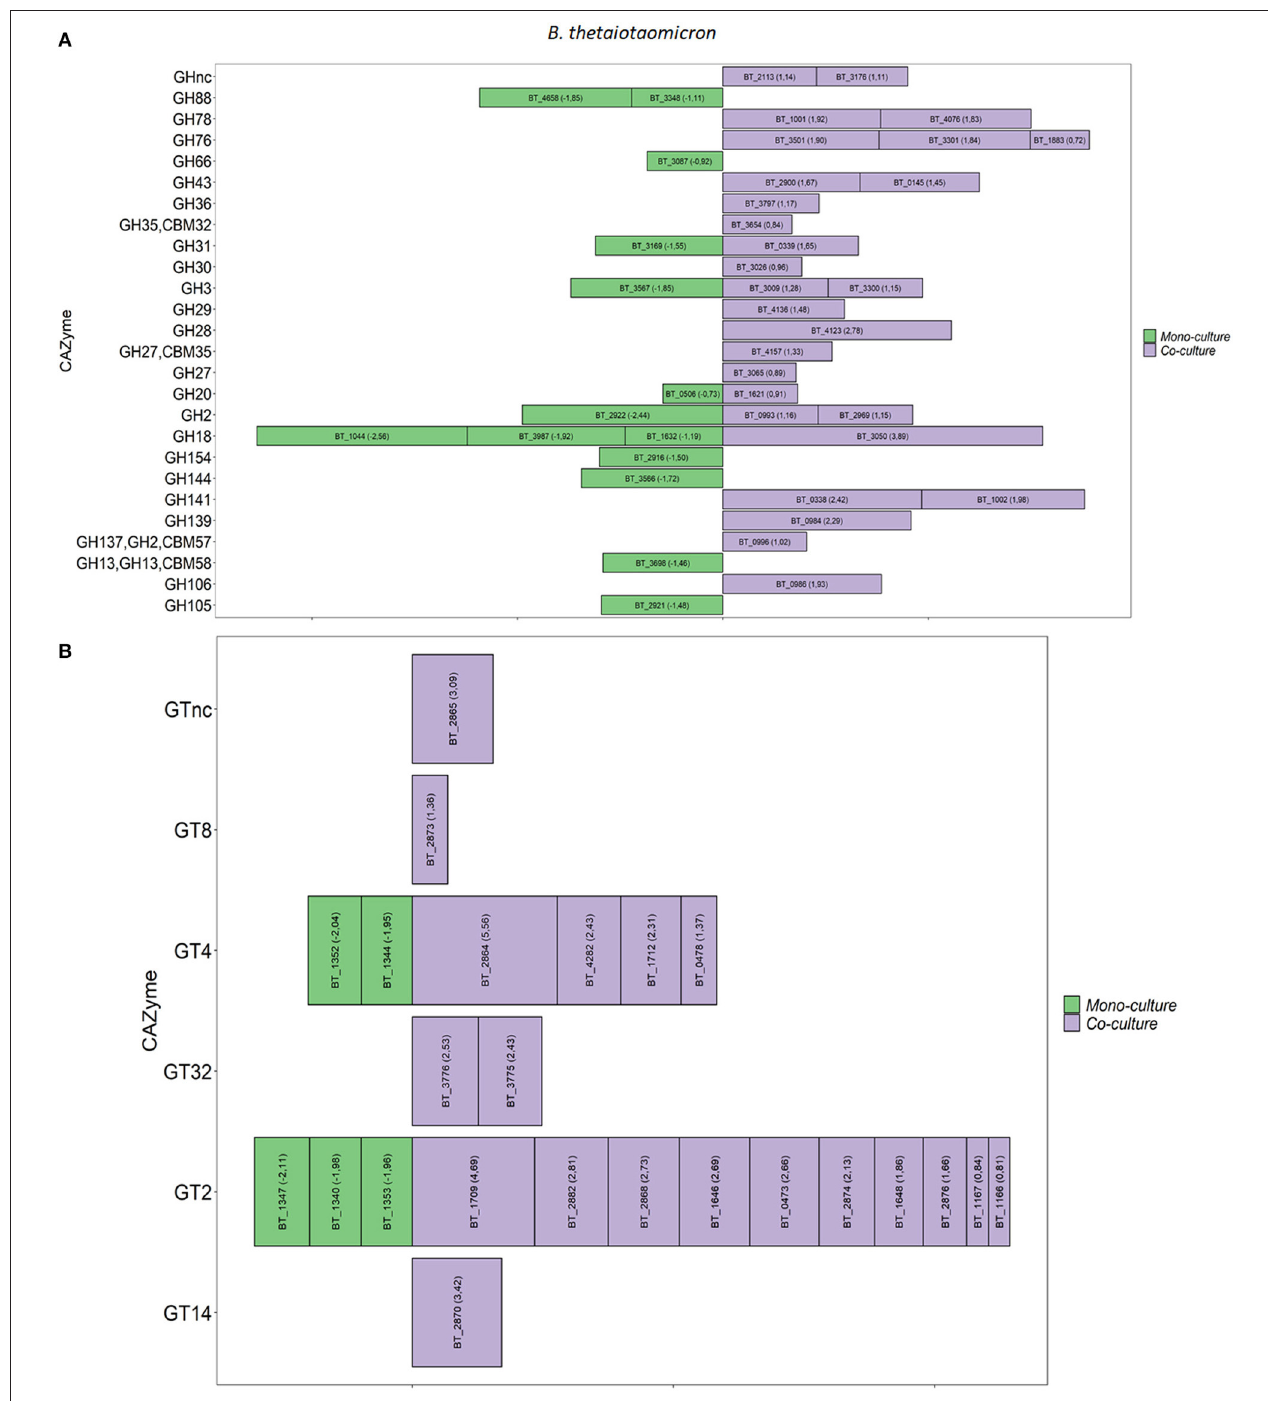
FIGURE 2 | Differential expression of GHs and GTs between mono and co-culture during in vitro fermentation. (A) B. thetaiotaomicron GHs, (B) B. thetaiotaomicron GTs. Only the CAZymes with adjusted p < 0.05 and Log2 Fold Change ≥ 0.58 are shown as averages. The size of each bar is proportional to the Log2 Fold change (the number between brackets within each